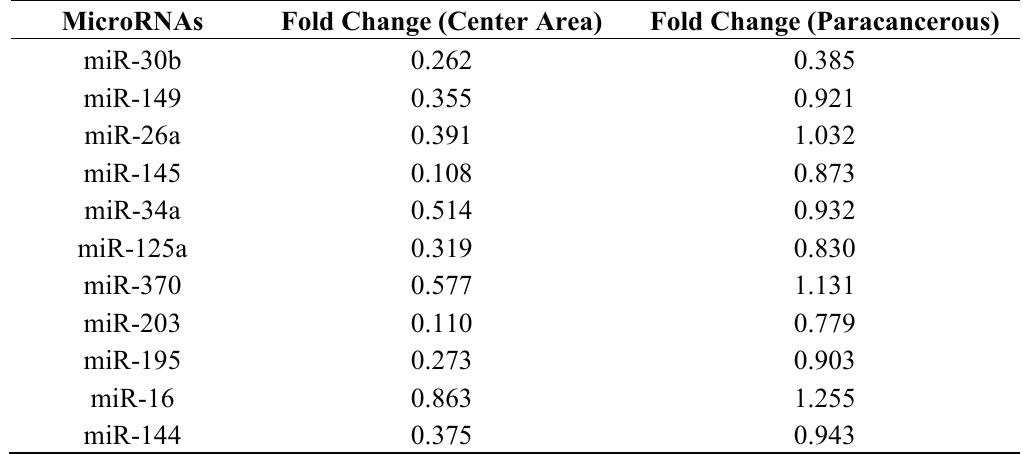
Table 1. Relative expression of microRNAs in center area and paracancerous compared with surgical